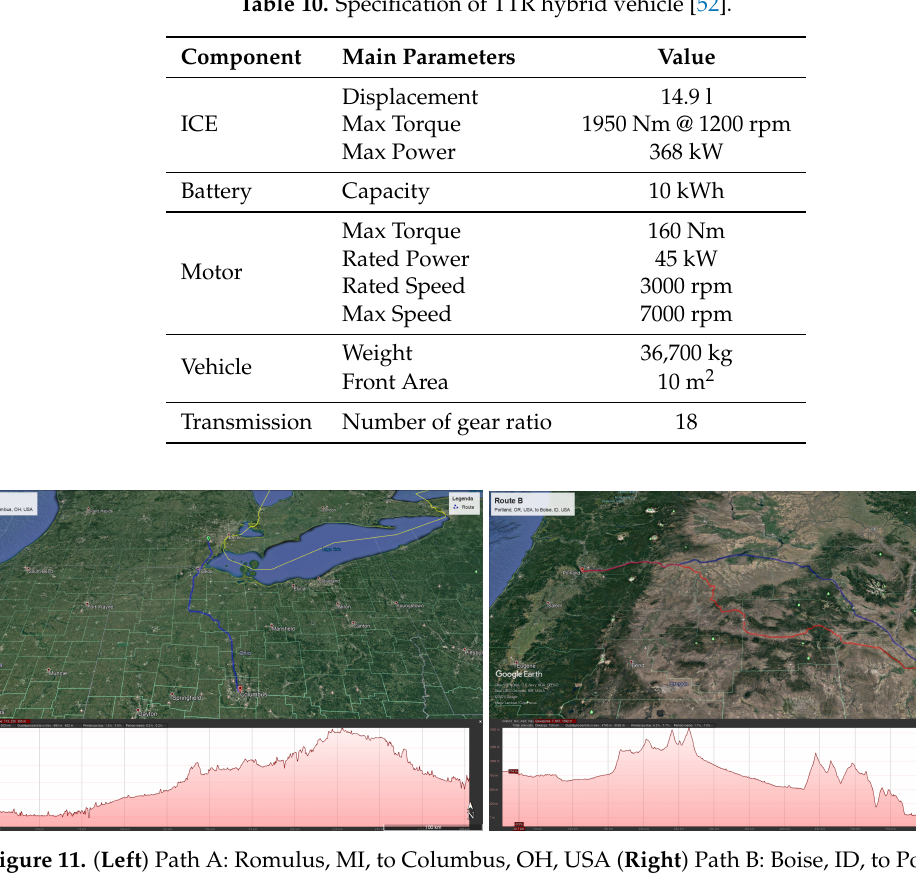
Figure 10. TTR truck powertrain schematic [52]. Table 10. Specification of TTR hybrid vehicle [52].